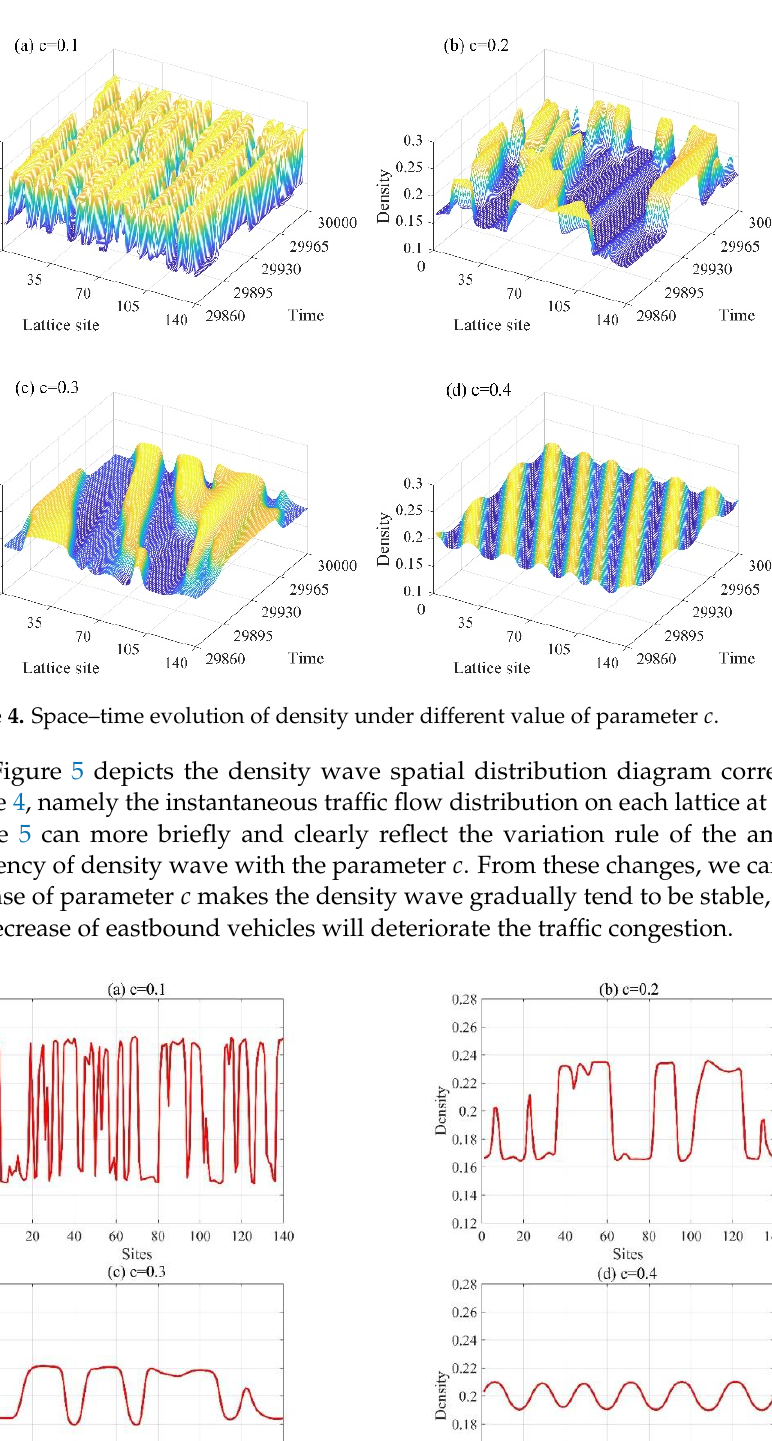
Figure 5. Density profile at t = 10,300 s corresponding to Figure 4.